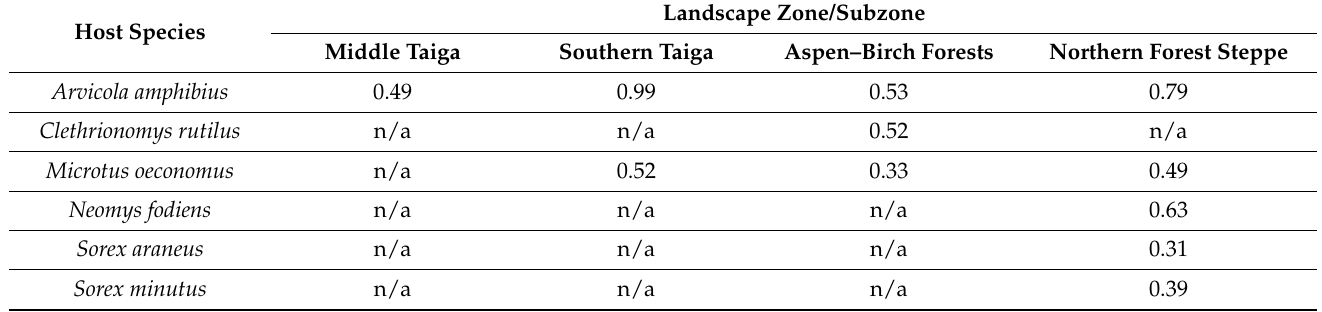
Table 2. Positive values of I P ( ≥ 0.31) calculated for different host species of I. apronophorus in different landscape zones (subzones) of West Siberia.